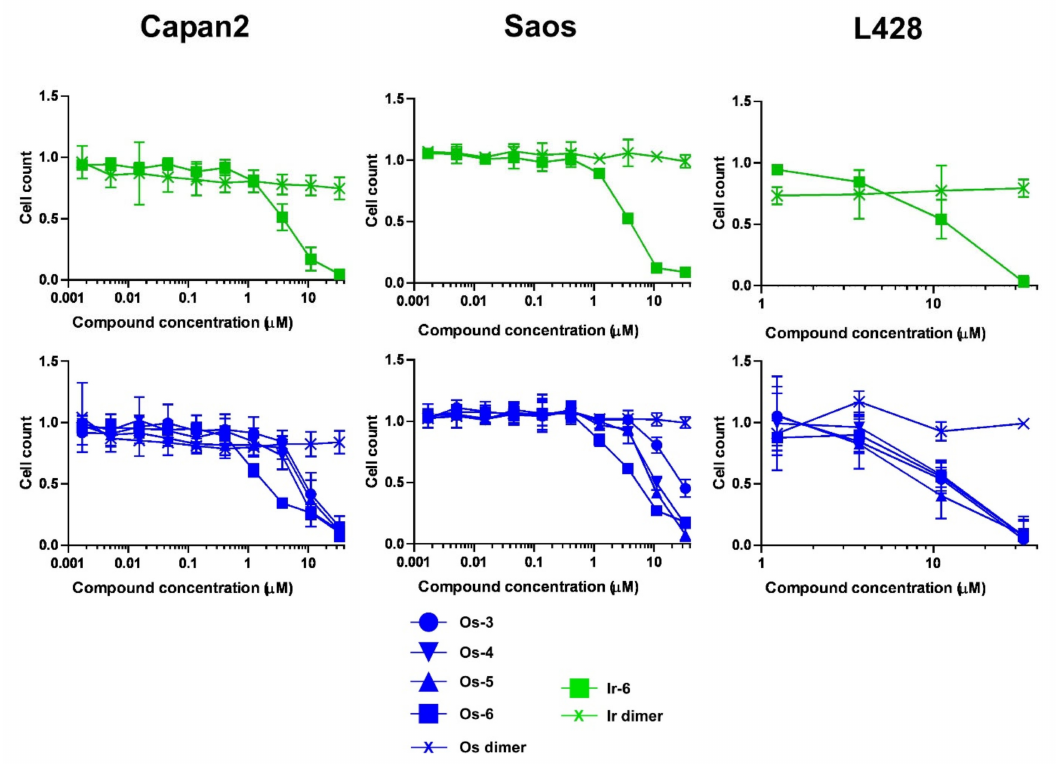
Figure 9. Assessment of selected Os(II) and Ir(III) complexes ( Os-3-Os-6 , Os-dimer , Ir-6 and Ir-dimer ) for cytostatic activity. Here, 1.5 × 10 3 Capan2, 3 × 10 3 Saos cells and 10 4 L428 cells